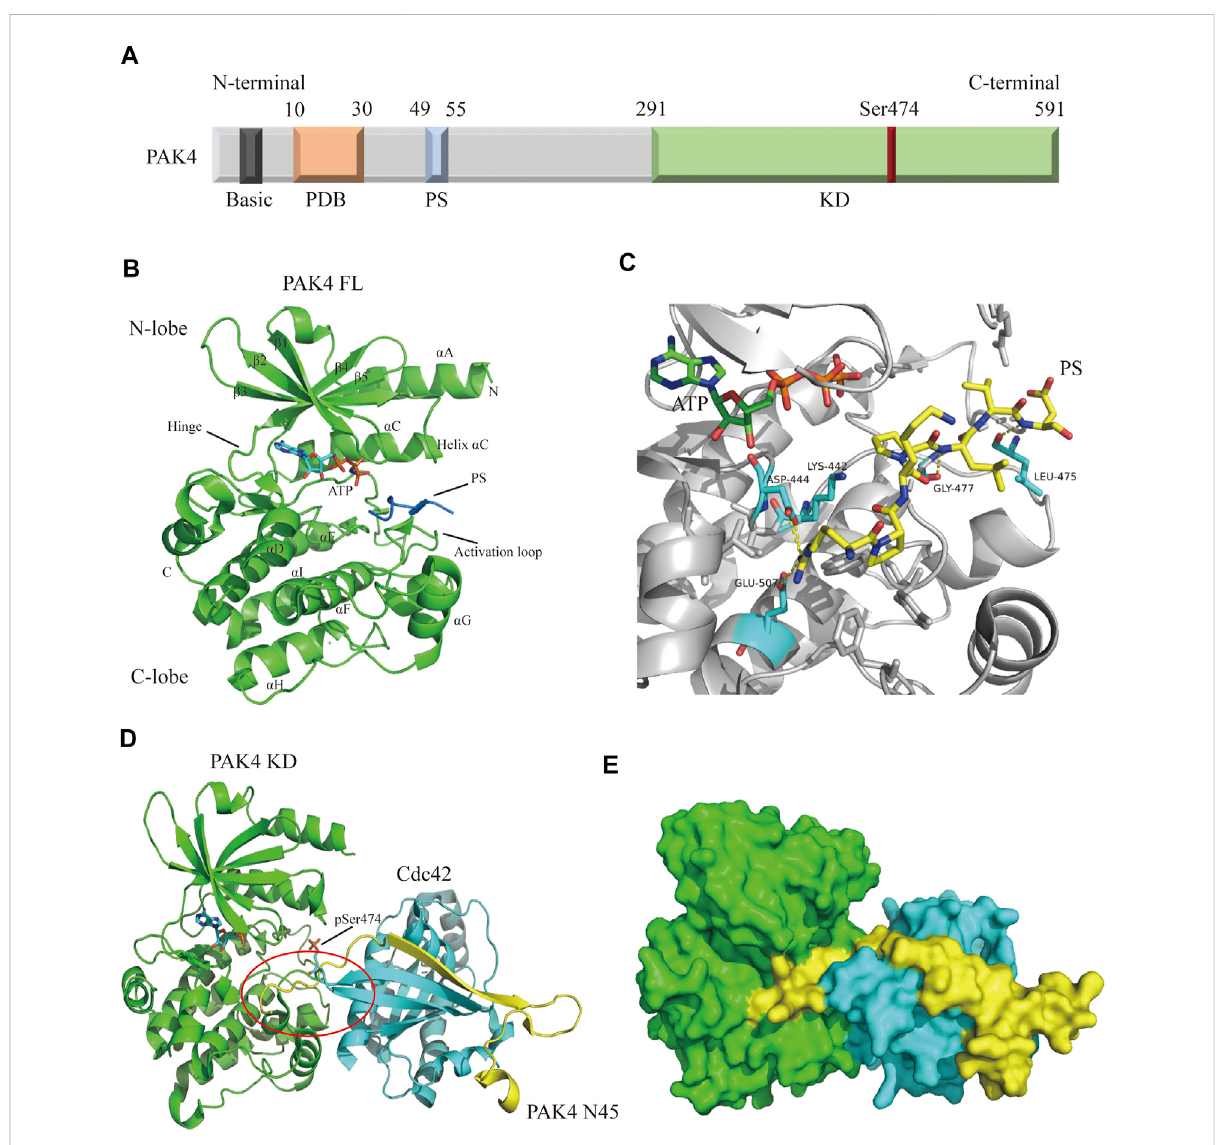
FIGURE 2 OverallstructureofPAK4. (A) SchematicdiagramofPAK4domainstructure.Theregionsarecoloredandlabeled.Aminoacidnumberofregions hasshown. (B) CrystalstructureofPAK4 FL(PDBcode:4FIE).Thesecondarystructureshavebeenlabeled.PSiscolored blue. (C) Thedetailedmodel of PS (yellow) binding to substrate binding site. Hydrogen bonds are colored yellow. (D) The ternary complex of PAK4 KD/PAK4 N45/Cdc42 (PDB code: 5UPK). PAK4 KD is colored green. PAK4 N45 is colored yellow. Cdc42 is color blue. (E) Surface diagram of the ternary complex which is shown in 2D. PDB: p21 binding domain, PS: Pseudosubstrate, KD: Kinase domain, FL: Full-length, N45: N terminus (residue